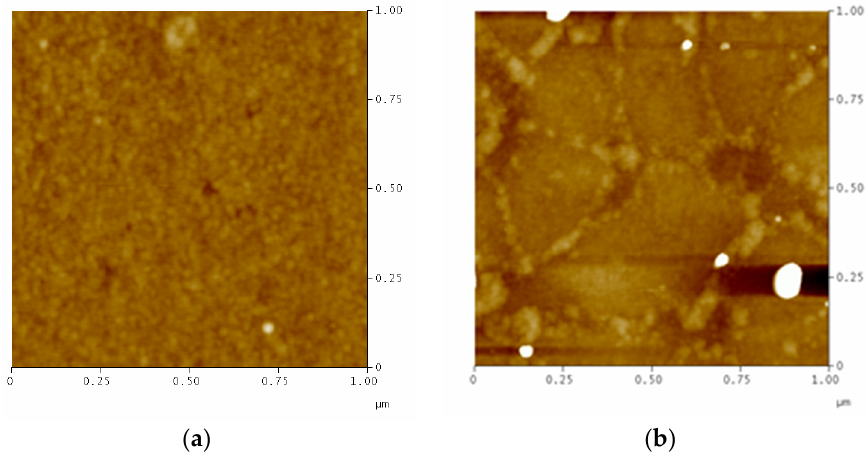
Figure 6. AFM pictures of 700 W WN x films, ( a ) as deposited and ( b ) annealed at 580 °C.